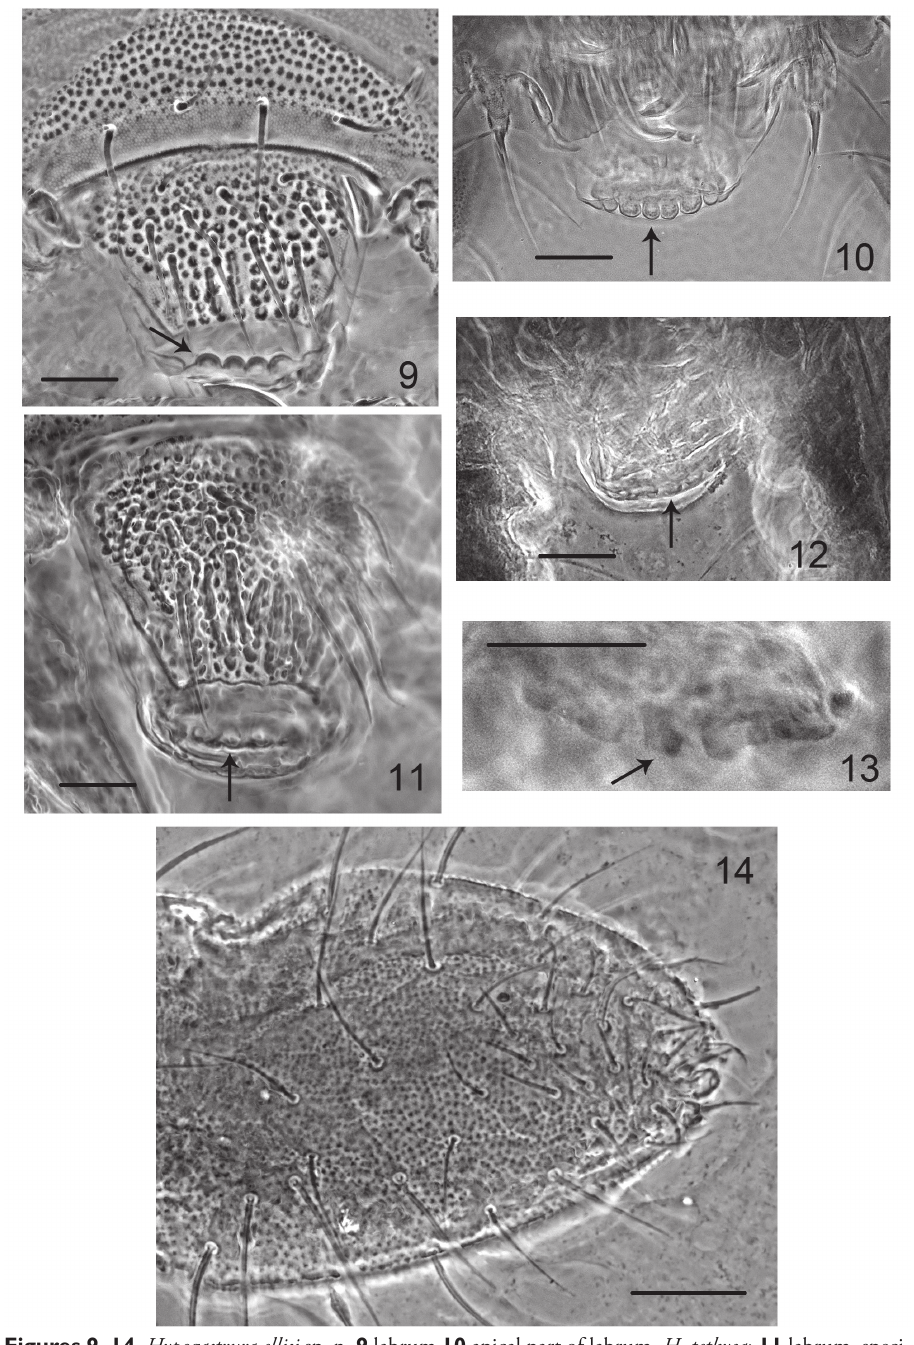
men from Azerbaijan 12 apical part of labrum, specimen from Crete 13 apical papillae, specimen from Crete 14 chaetotaxy of ventral side of Ant. IV. Black arrows indicate apical papillae. Scale bars: 0.01